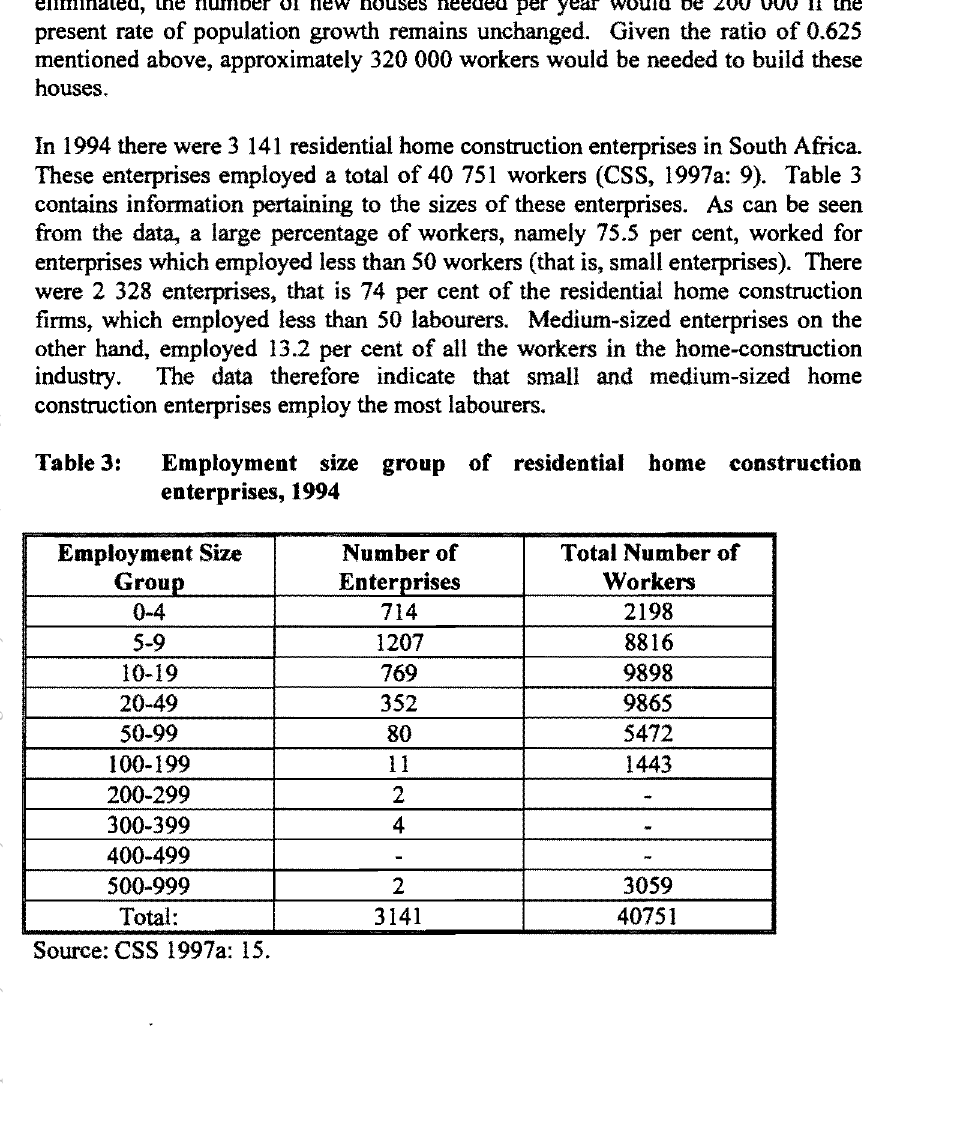
Employment size group of residential home